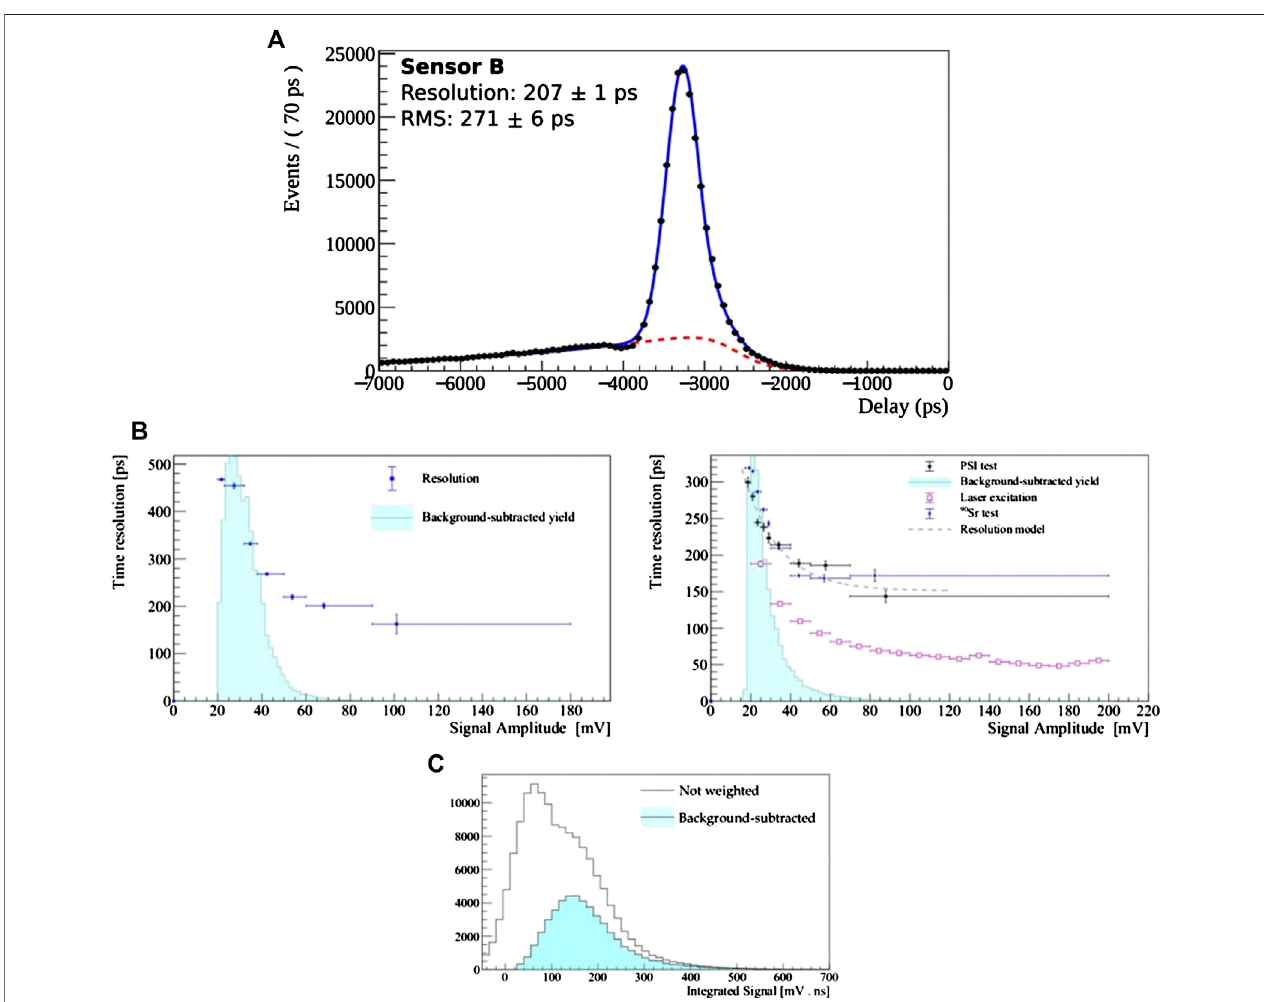
FIGURE15|(A) Fitofthedelaydistribution withaCrystalBallfunctionsuperimposed tonon-peakingbackground. (B) StudyoftheresolutionofthesensorsAand B, respectively, in bins of the signal amplitude. The histogram of the signal amplitude obtained with the s P lot technique applied to the 90 Sr dataset is superimposed. For SensorA,onlytheresolutionobtainedwith 90 Sr β raysisreported,whileforSensorBtheresultsobtainedwith 90 Srelectrons,highenergypionsandlaserexcitationsare compared. (C) Application of the s P lot technique to the integrated signal. The white histogram represents the distribution of the integrated signal on the whole dataset,while thecyanhistogram isobtainedbyweightingtheeventstostatisticallysubtractthebackgroundcontribution.The30-cellstrip ofSensorBwastakenasan